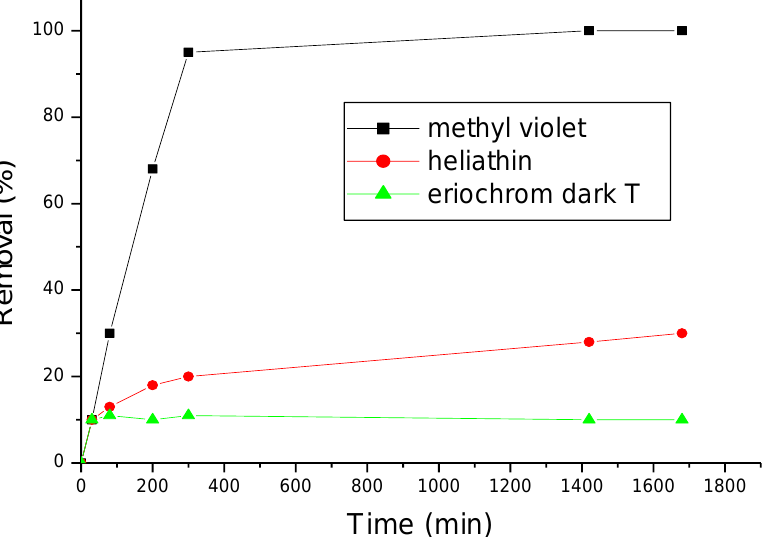
Figure 4. Adsorption of the three dyes on ß-cyclodextrin polymer, dyes concentrations 2.5 10 −5 mol.L −1 , ß-cyclodextrin polymer amount 20 mg, T = 30 °C.